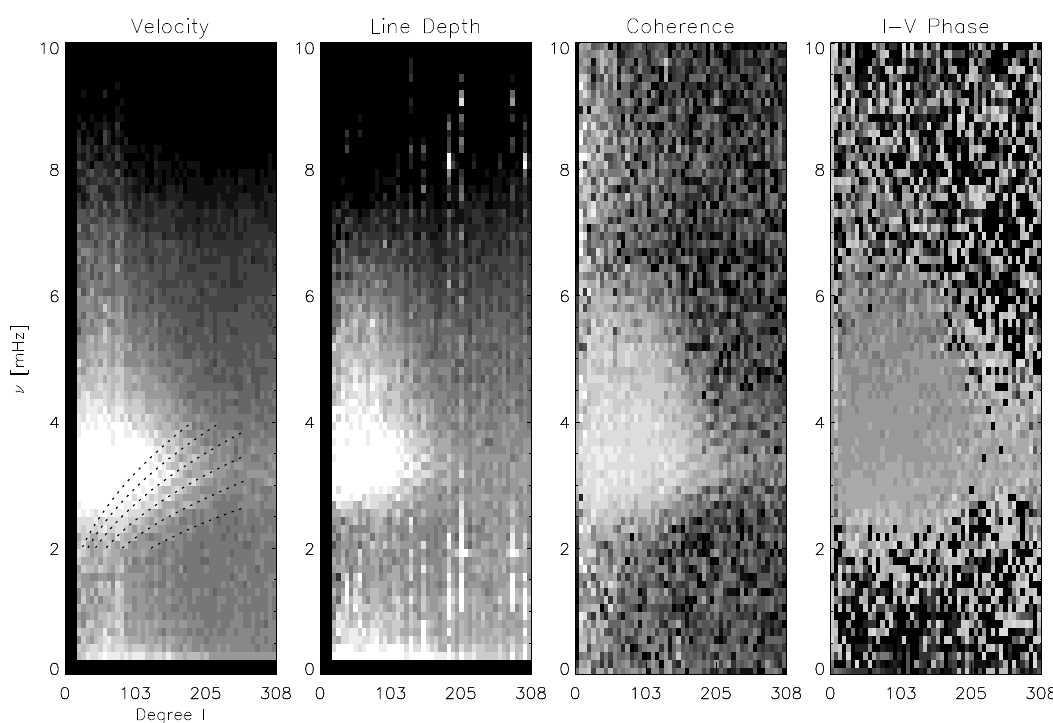
Figure 8: Diagnostic l- 𝜈 diagrams for full disk oscillations observed with the Doppler shifts and depths of CO 4666 nm lines. The CO oscillations show the same power ridges as the global p-mode oscillations, but show an I-V phase which is different from the expected adiabatic phase shift and which allows an investigation of the dynamics of the solar atmosphere. Image reproduced with permission from Penn et al. (2011), copyright by